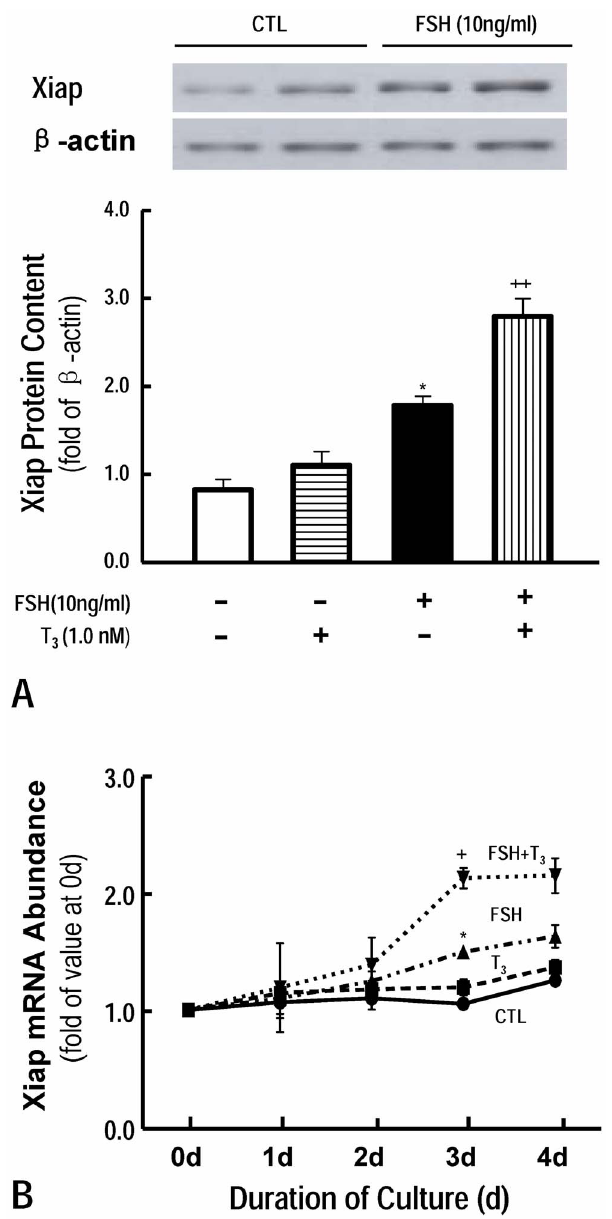
Figure 4. Effect of FSH and T 3 on follicular Xiap expression in vitro . Results are represented as means 6 SEM of four independent experiments. Note that T 3 , although ineffective alone, significantly increased FSH-induced Xiap expression (T 3 1.0 nM; P , 0.01). *: P , 0.05 vs CTL. + : P , 0.05, ++ : P , 0.01vs FSH alone (Two way ANOVA)